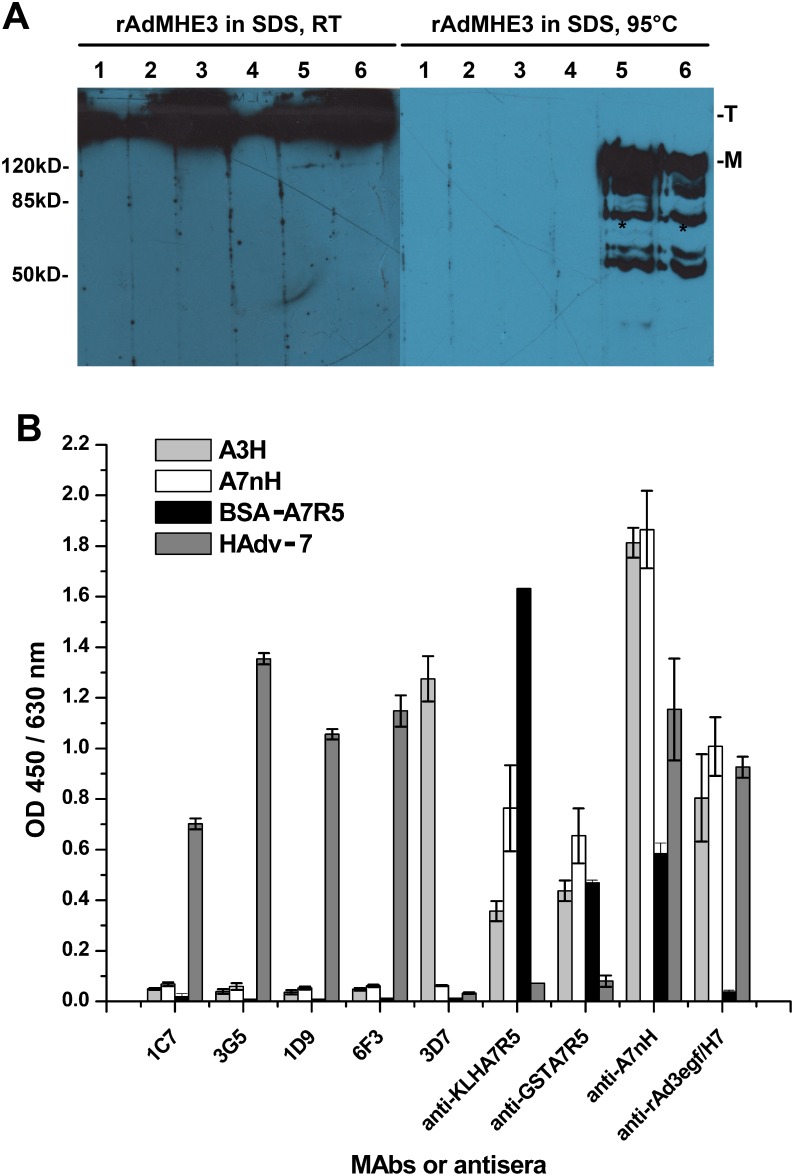
Characterization of the neutralizing epitopes within HVR5 of HAdv-7.(A) Immunoblotting analysis indicated that the four HAdv-7-neutralizing MAbs recognized hexon in trimeric form (T) at room temperature (RT), but not the hexon monomers (M) at room temperature or heated at 95°C for 5 min, in the presence of SDS. HEp-2-cell-cultured rAdMHE3 virions were harvested and stored at room temperature or heated at 95°C for 5 min in the presence of SDS. The samples were then separated by SDS-PAGE and tranferred onto nitrocellulose membranes. The membranes were then cut into individual strips and incubated with individual MAb or antiserum. After the blot being developed, the strips were spliced and their signals were exposed to two pieces of X films. The MAb 3D7, which bound to the recombinant HAdv-3 hexon protein, and the anti-rAdMHE3 serum were used as the positive controls. Lane 1, 1C7; lane 2, 3G5; lane 3, 1D9; lane 4, 6F3; lane 5, 3D7; lane 6, anti-rAdMHE3. *The rAdMHE3 virus suspensions were stored at −20°C for several months, so there may be degradation for some hexon, which may explain the minor bands of less than 120 kDa. (B) HAdv-7 virions, recombinant truncated hexon fragments of HAdv-3 (A3H) or HAdv-7 (A7nH), and BSA-conjugated synthetic HAdv-7 HVR5 peptide (BSA-A7R5) were reacted with the MAbs or different antisera in indirect ELISAs. The MAbs did not react with BSA-A7R5, A3H, or A7nH. Both anti-KLHA7R5 and anti-GSTA7R5 bound to HAdv-7 virions weakly. In addition, anti-rAd3egf/H7 bound to BSA-A7R5 weakly as well. Each experiment was repeated independently at least three times, and the mean values and standard deviations (indicated by the error bars) are shown.